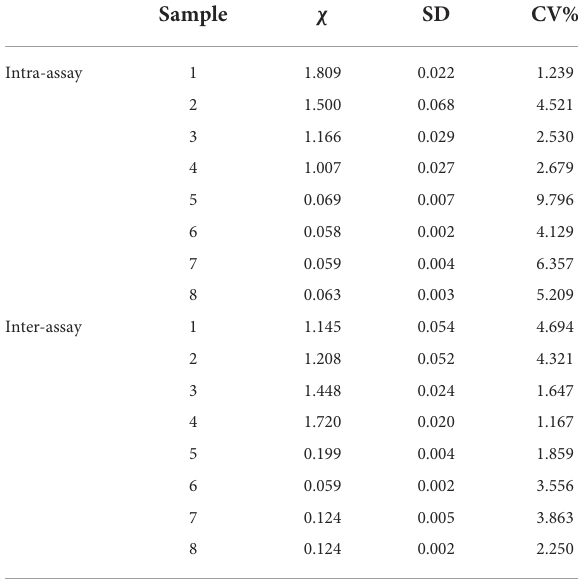
TABLE 2 Determination of Cap based ELISA coefficient of variation (CV) from eight negative serums (1–4: positive serum; 5–8: negative